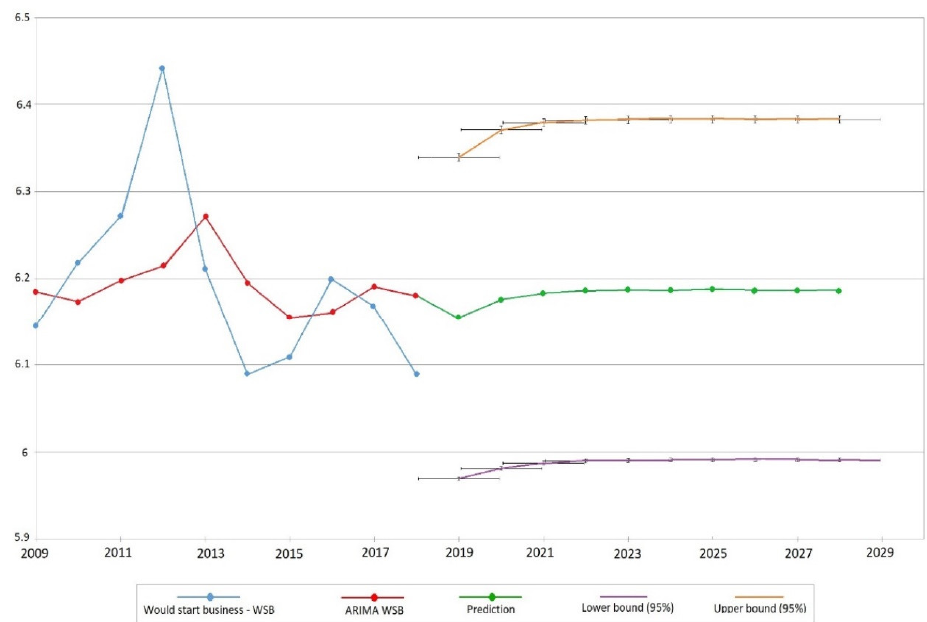
Figure 3. ARIMA forecasting graph (without predictors).